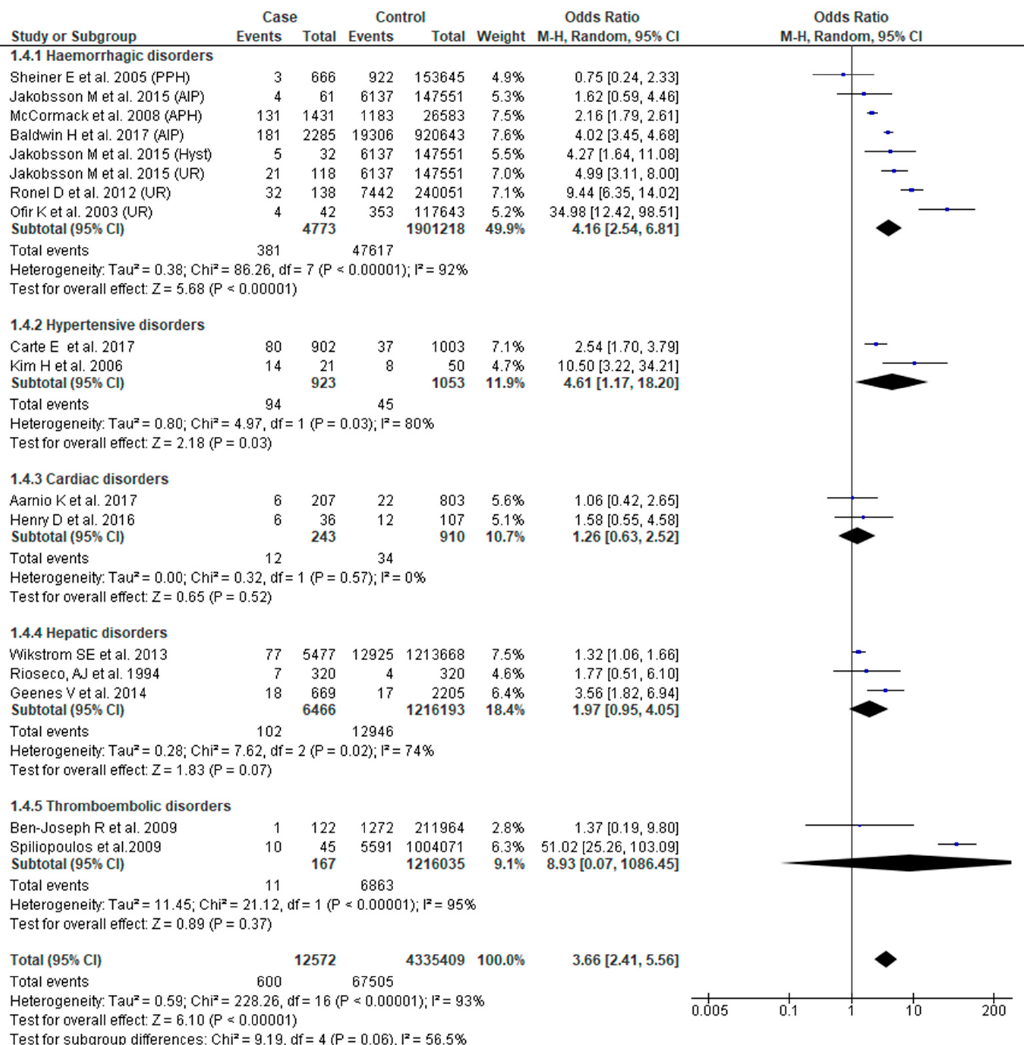
Figure 5. Forest plot of studies assessing association between SMM and 5-min Apgar score < 7.